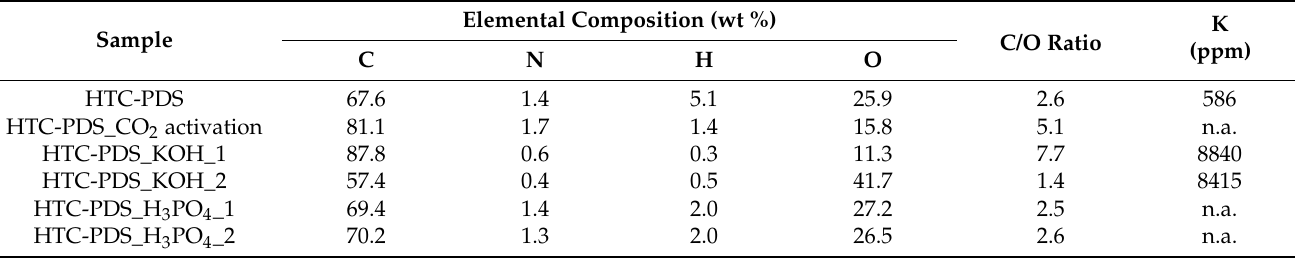
Table 1. Elemental analysis of the parent HTC-PDS and the respective activated materials. n.a. = not available. Sample